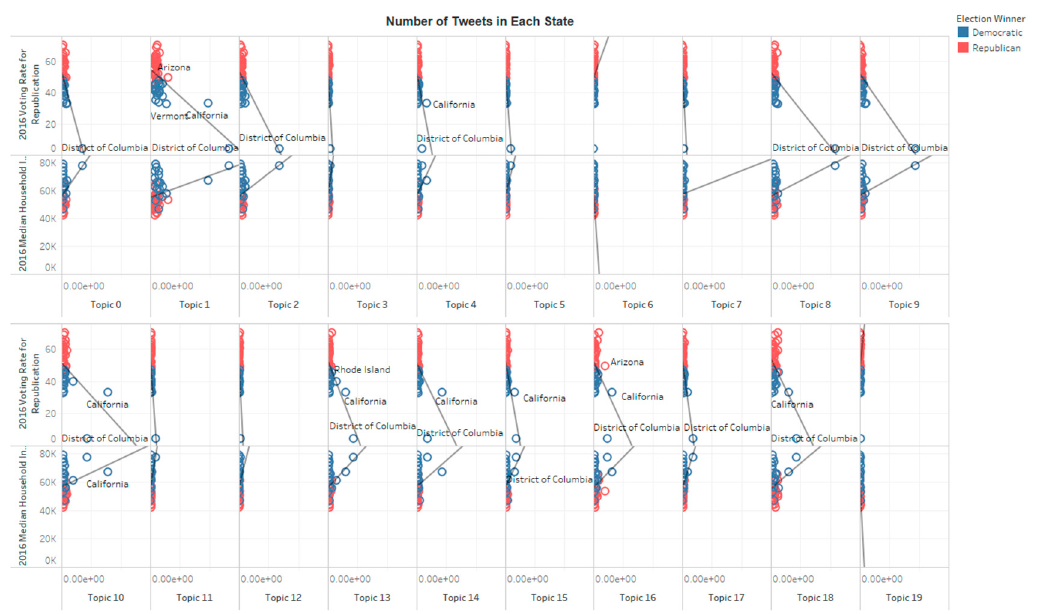
Figure 14. Number of Tweets in each state.